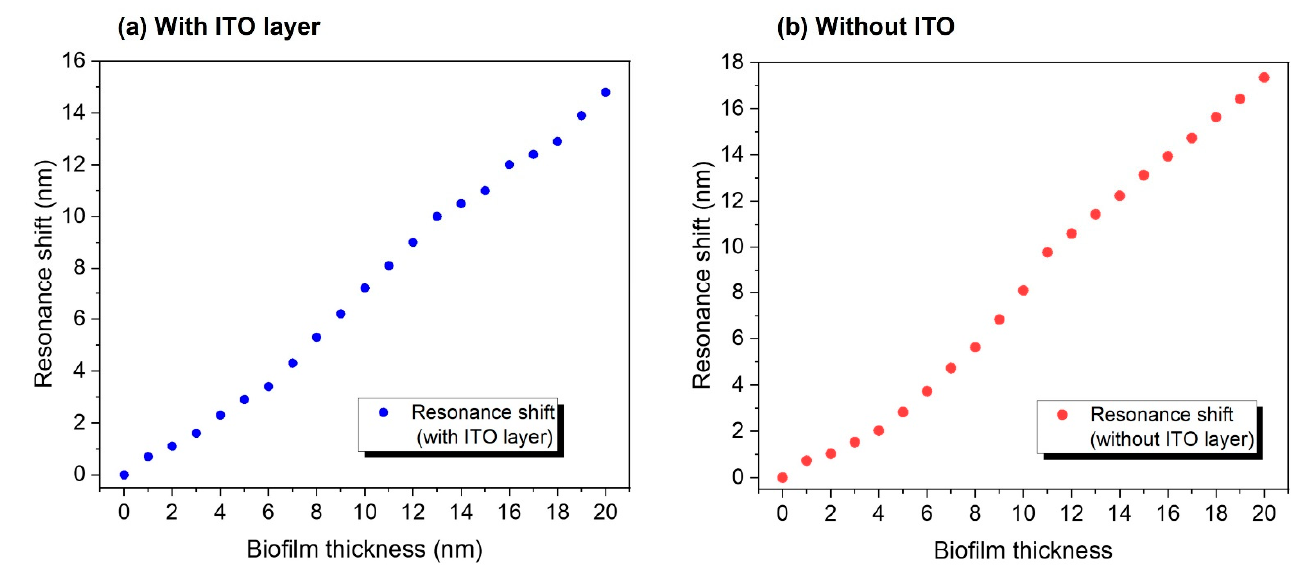
Figure 7. Resonance shift as a function of biofilm thickness. ( a ) Resonance shift for pillars covered with a 25 nm of porous ITO layer, with a RI of 1.585, adding a biolayer with a constant index of 1.41. ( b ) Resonance shift of the pillars without considering the ITO layer.